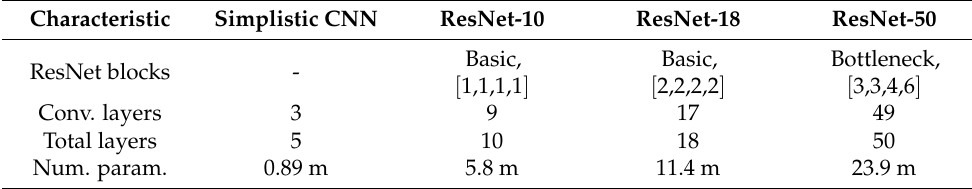
Figure 4. Architecture of the 5 layer Simplistic CNN with less than 1 million parameters. Table 2. Comparison of parameters of studied DL CNN